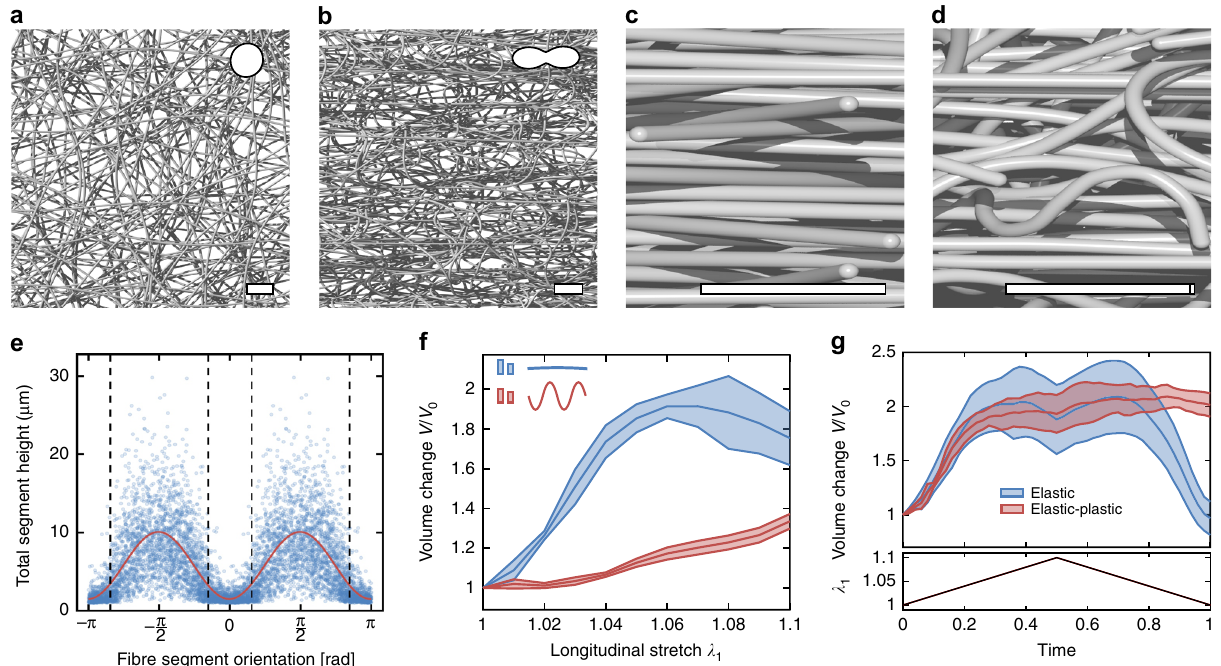
¼ 1 μ m at 0% ( a ) and 10% ( b ) strain. c , d Close-up side view of a Fig. 3 Finite element simulations. a , b Close-up top view of a simulated network with d F simulated network at 0% ( c ) and 10% ( d ) strain. Scale bar in ( a – d ) 10 μ m. Pictograms in ( a , b ) show polar plots of descriptive von Mises distributions. e Scatter plot showing the total segment height at 10% strain vs. initial segment orientation displayed from (cid:2) π to π by use of symmetry. Trend line (red) to guide the eye, obtained by fi tting the fi rst three terms of a Fourier series. Dashed lines separate the domains, in which segment stretches are tensile or compressive, respectively, according to the af fi ne model with aspect ratio a ¼ 17 : 67. f Volume change for nearly straight segments (sine shaped fi bres with ¼ 7 μ m and wavelength Λ ¼ 150 μ m) and highly undulated segments (sine shaped fi bres with α ¼ 2 μ m and Λ ¼ 10 μ m) with applied amplitude α F F F F ¼ 7 μ m, stretch λ 1 . g Volume change when loading and unloading a network with elastic (blue) and elastic-plastic (red) fi bres, respectively, ( α F Λ ¼ 150 μ m). The lower diagram shows the applied stretch λ N = 3 network realisations and given as 1 over normalised time. Data in ( f , g ) are averages of F mean and standard deviation (shaded